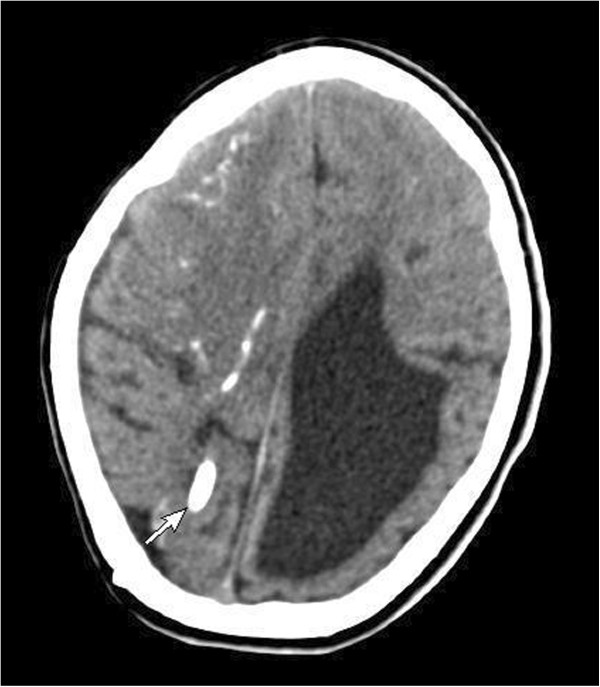
Computerized tomography of brain showing dilated ventricles with multiple subependymal and parenchymal calcifications (arrow).